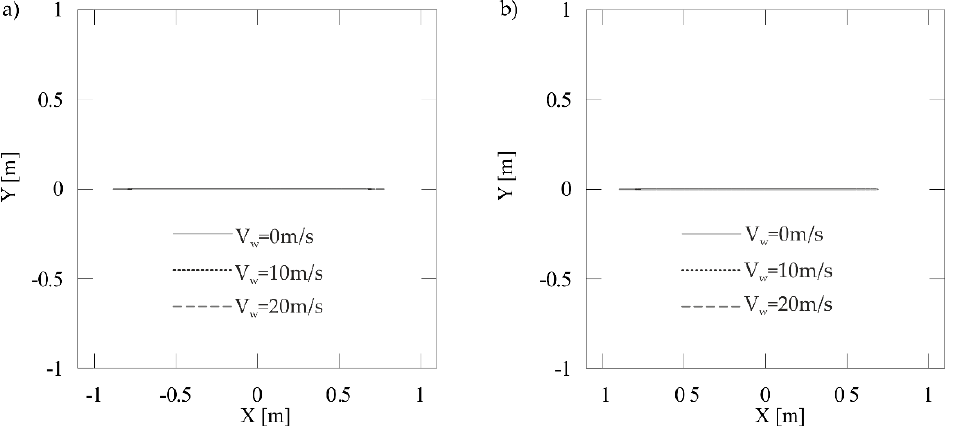
Figure 5. Projection of the trajectory of the carried load’s suspension point on the rotation plane for ( a ) the variable effective area and ( b ) fixed effective area.